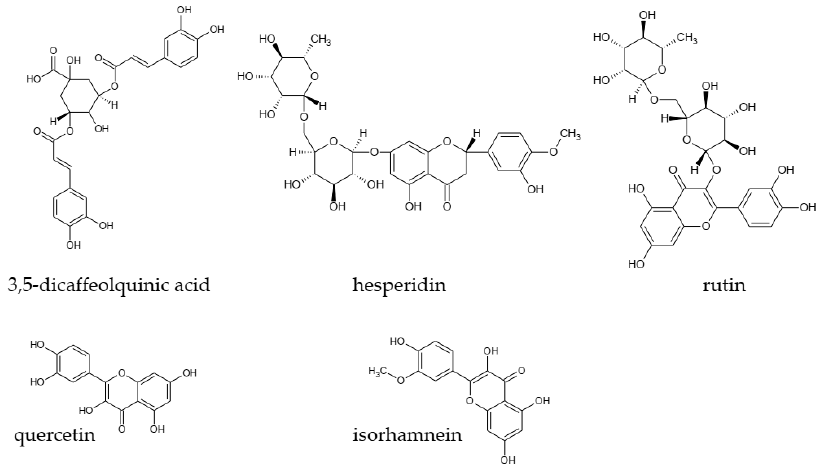
Figure 1. Structures of reference substances used for identification.